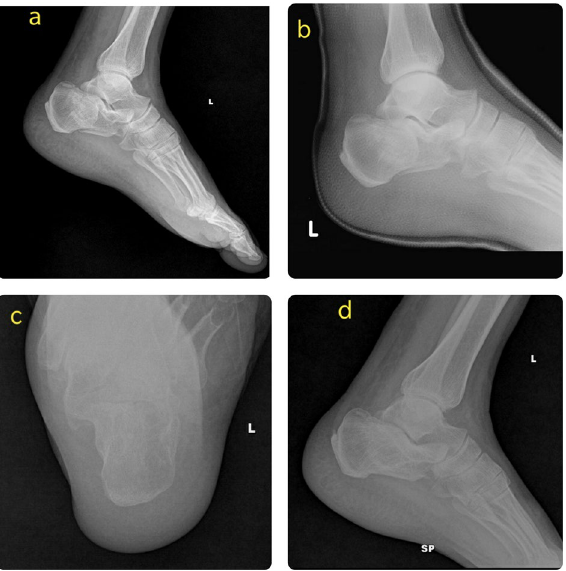
Figure 1. Calcaneal fracture treated by non-operative method. ( a ) Post injury radiograph, ( b ) radiograph after casting, ( c , d ) radiographs at one year follow